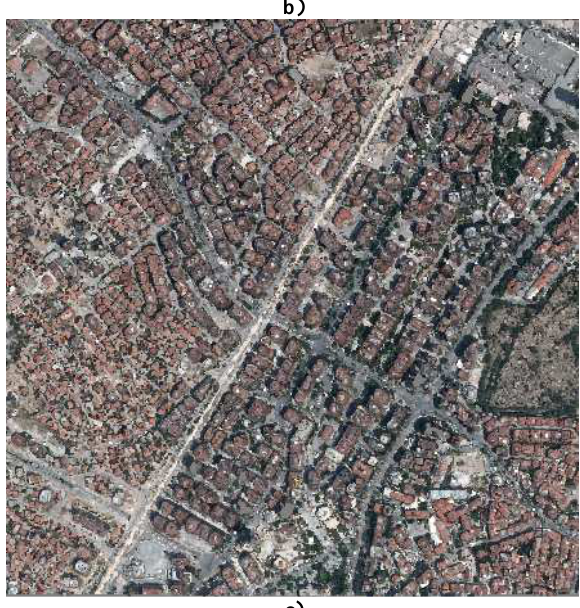
Figure 4. Point cloud data of the study area. a) The date of 1951,